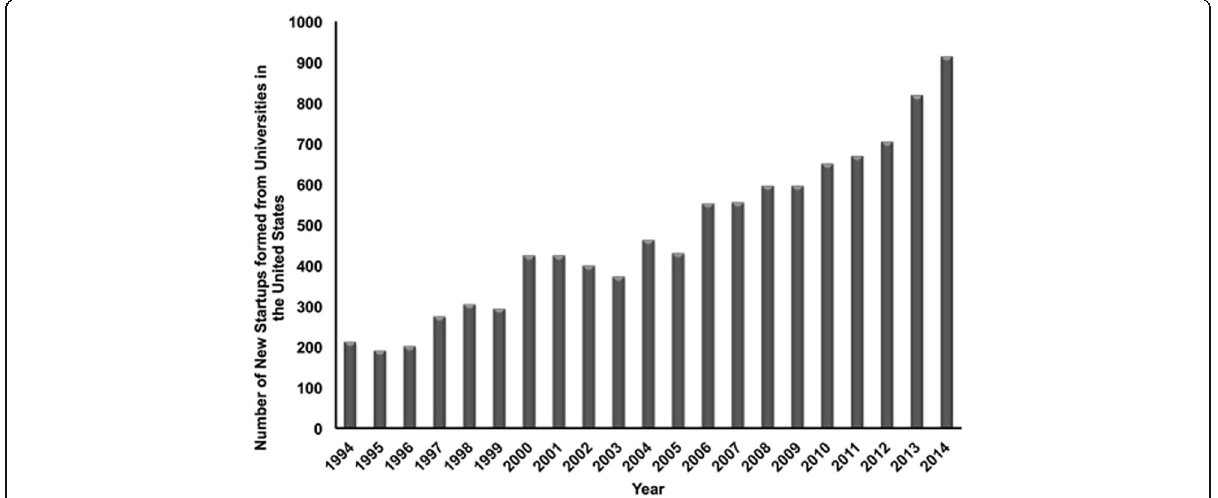
Fig. 1 New startup companies formed from universities in the United States from 1994 to